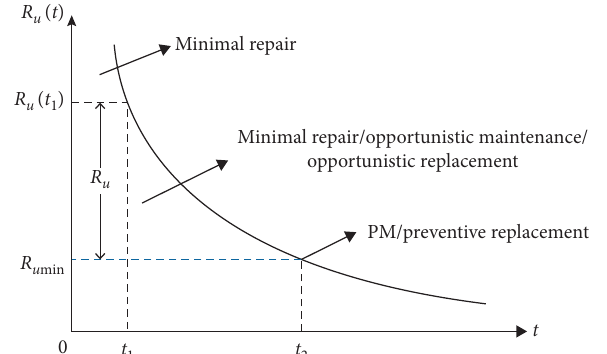
Figure 5: The OM reliability threshold of component